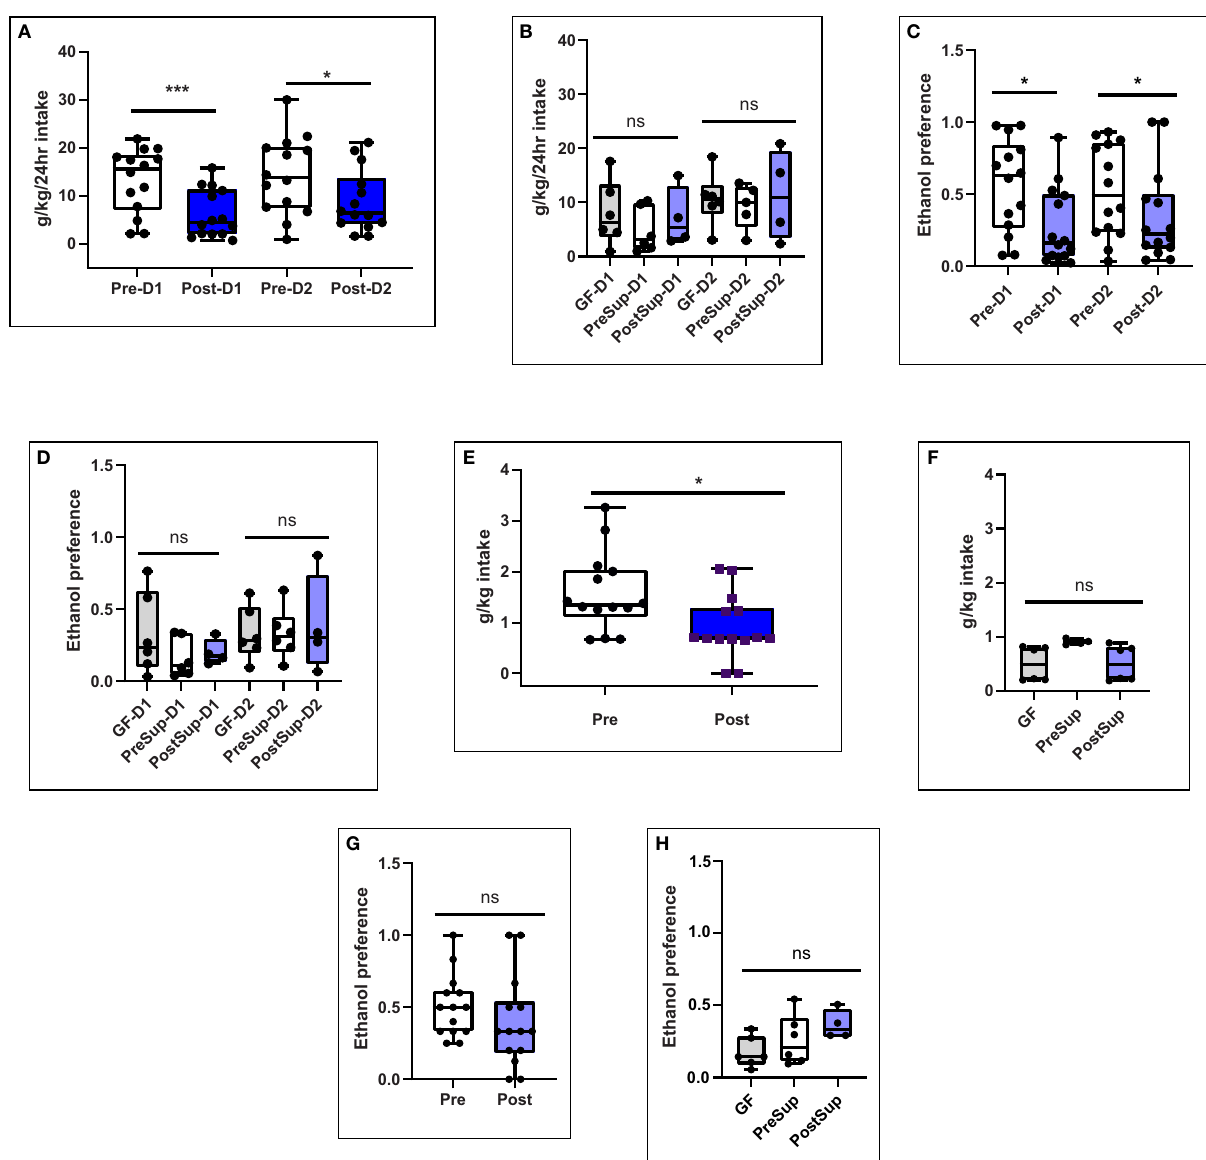
Fig.2|AlcoholIntakeandpreferenceisreducedinpost-FMTmalemice.A , B 24- hour two-bottle choice alcohol intake for 20% ethanol or water on days 1 and 2. A Pre and post-FMT stool colonized mice (D1 comparison p =0.0058, D2 com- parison p =0.035) using one-sided Mann – Whitney tests, B Germ-free mice and those colonized using sterile supernatants from pre and post-FMT mice were not signi fi cantly different using using one-sided Kruskal – Wallis tests. C Pre and post- FMT stool colonized mice, D Germ-free mice and those colonized using sterile supernatants from pre and post-FMT mice. E – H Initial alcohol intake and pre- ference measured during the 2-h initial binge on day 1. E Pre-FMT stool colonized mice had lower intake in the binge than post-FMT stool colonized mice ( p =0.03,